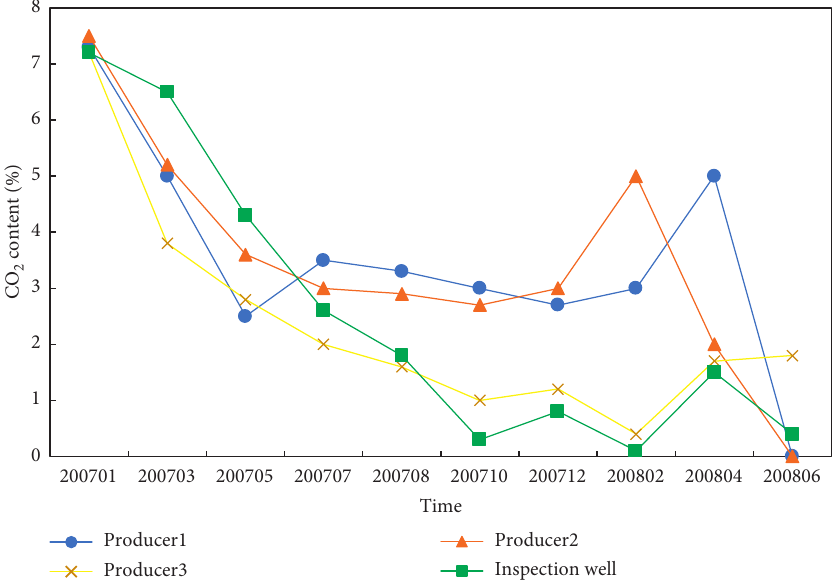
Figure 11: CO 2 content in natural gas from B-1-D oil producers [80].